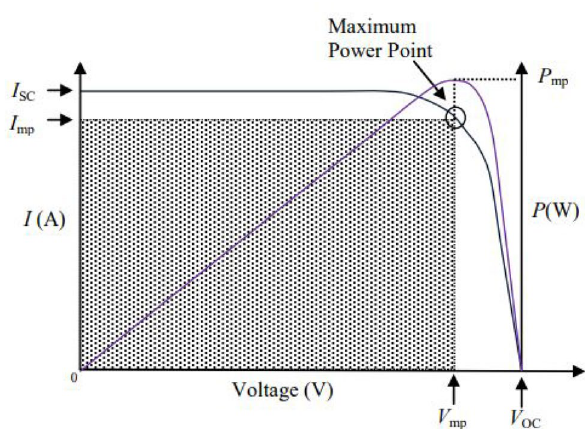
Figure 2. I(V) characteristic curve of a solar cell (Adapted from 11